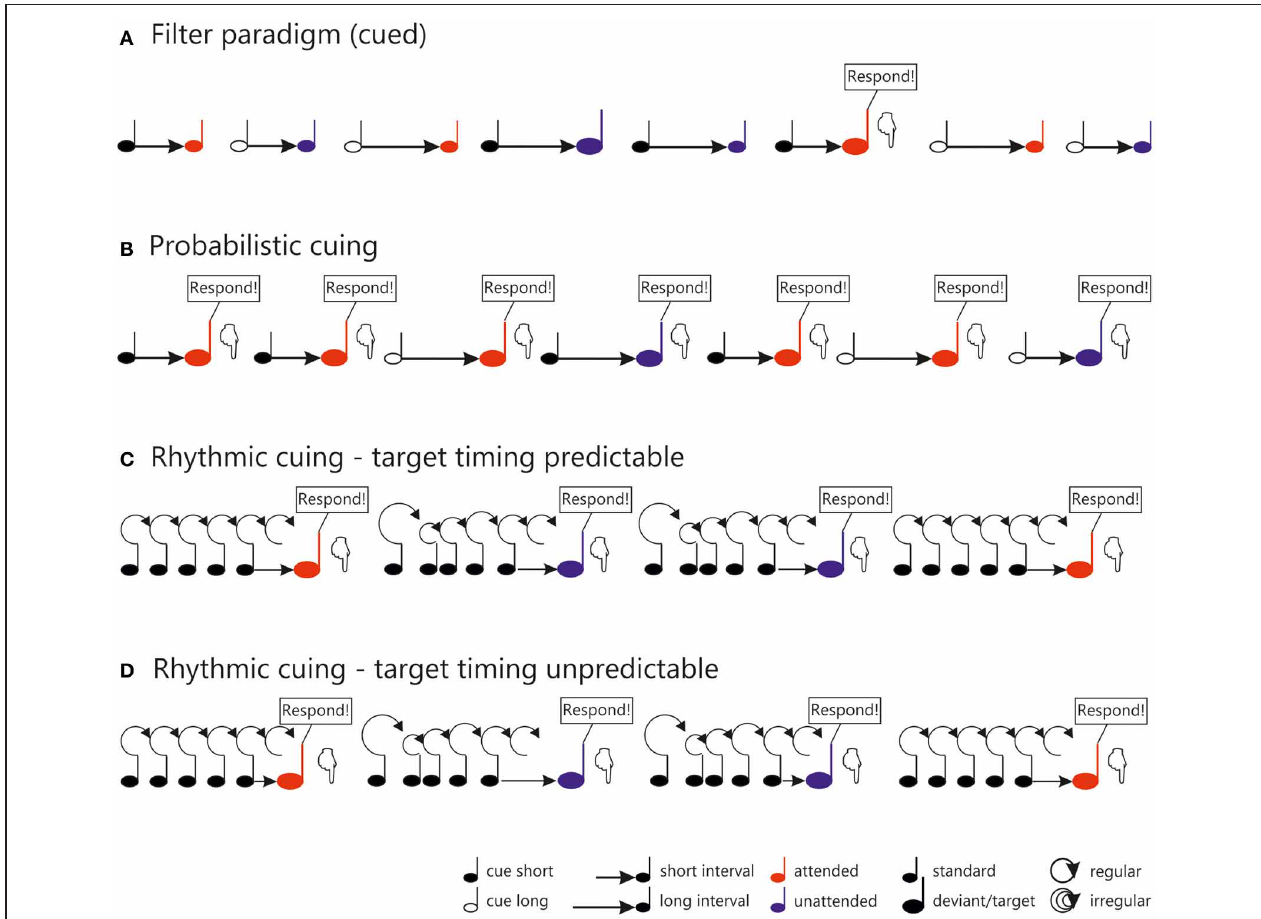
FIGURE 1 | General outlines of stimulus configurations used in different temporal orienting tasks. In the cued filter paradigm (A) , as used e.g., in Lange (2012a), each trial consists of a symbolic cue (black note symbol) indicating whether the short (filled) or the long (unfilled) interval has to be monitored for deviant sounds. Frequent standard sounds (small note symbols) and infrequent deviantssounds (large note symbols) follow the cue after a short or long interval (indicated by the length of the arrow). Standards and deviants presented at attended and unattended time points are marked by red (attended) and blue (unattended) note symbols, respectively. In this paradigm, only attended deviants require a response, as indicated in the figure. In the probabilistic cuing paradigm (B) as used in Lampar and Lange (2011, Experiment 1), the symbolic cue (black note symbol) indicates the time point,